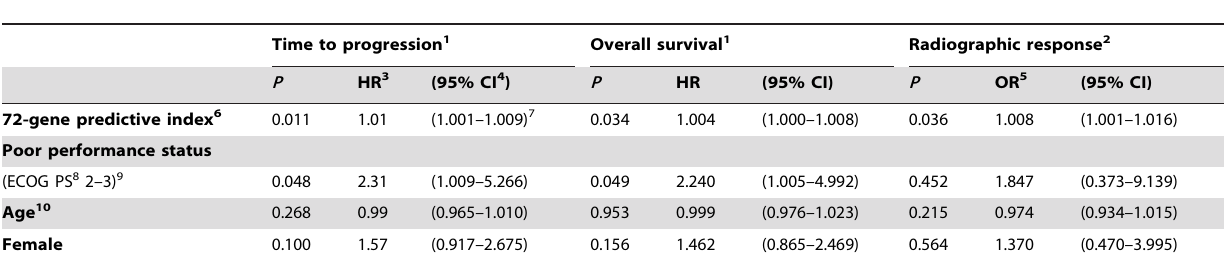
1 Result of the Cox regression analysis performed for 101 patients. 2 Result of the ordinal logistic regression analysis performed only in 88 patients with measurable disease, using 3 categories of the dependent variable (PR, SD, and PD). 3 Hazard ratio. 4 Confidence interval. 5 Odds ratio. 6 Weighted linear combination of log signal values of 72-gene acquired resistance signature. The univariate t -statistics for comparing the acquired chemoresistant state with the pretreatment state were used as the weights. 7 Hazard ratio for each unit increase in 72-gene predictive index, which ranges from 1,783 to 2, 075 ( i.e. , the highest predictive index (2,075) and median predictive index (1,945) are associated with hazard ratios of 4.3 (=1.005 292 ) and 2.2 (=1.005 162 ), respectively, compared with a hazard ratio of 1.0 with the lowest predictive index (1,783) of all 101 samples). 8 Eastern Cooperative Oncology Group Performance Status.